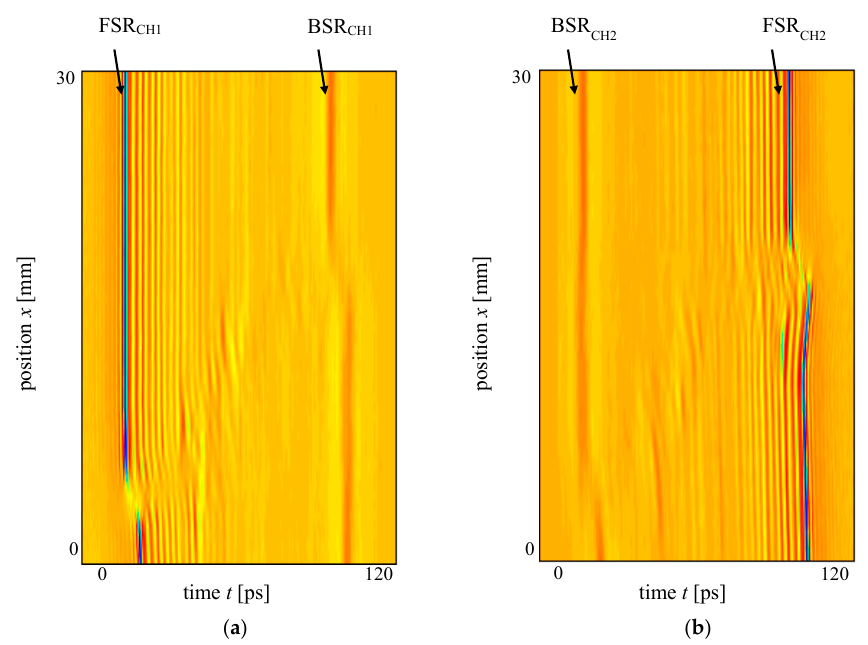
Figure 12. B-scan signals prepared for weighted summing: ( a ) deconvolved channel 1 signal g mCH1 ( t , x ); and ( b ) time reversed channel 2 signal g mCH2 ( − t , x ).